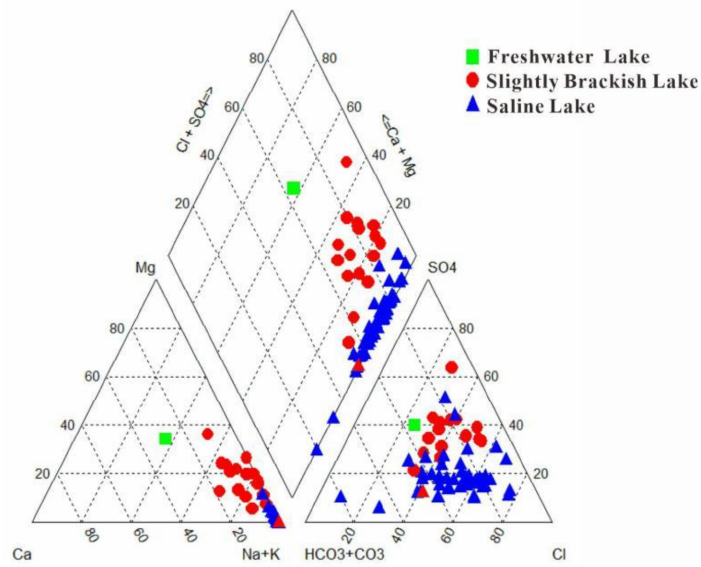
Figure 3. The Piper diagram of lake water in the Badain Jaran